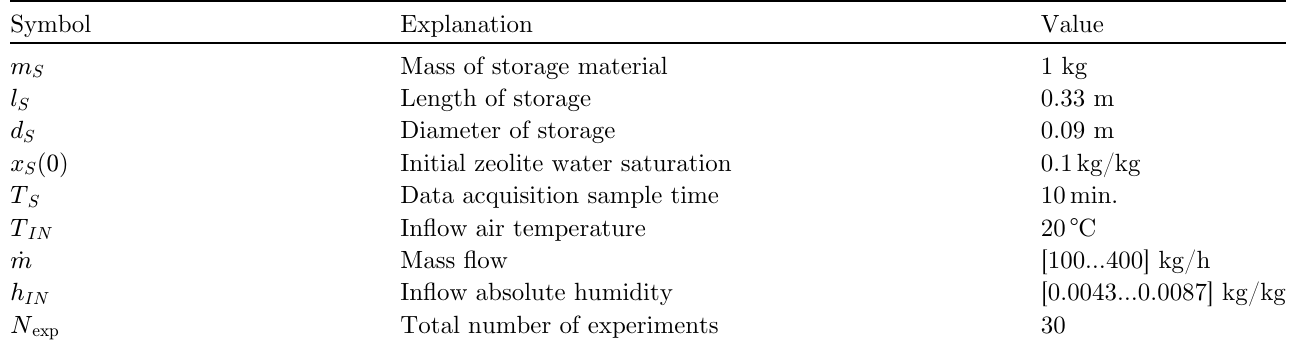
Table 1. Symbols and values used in the